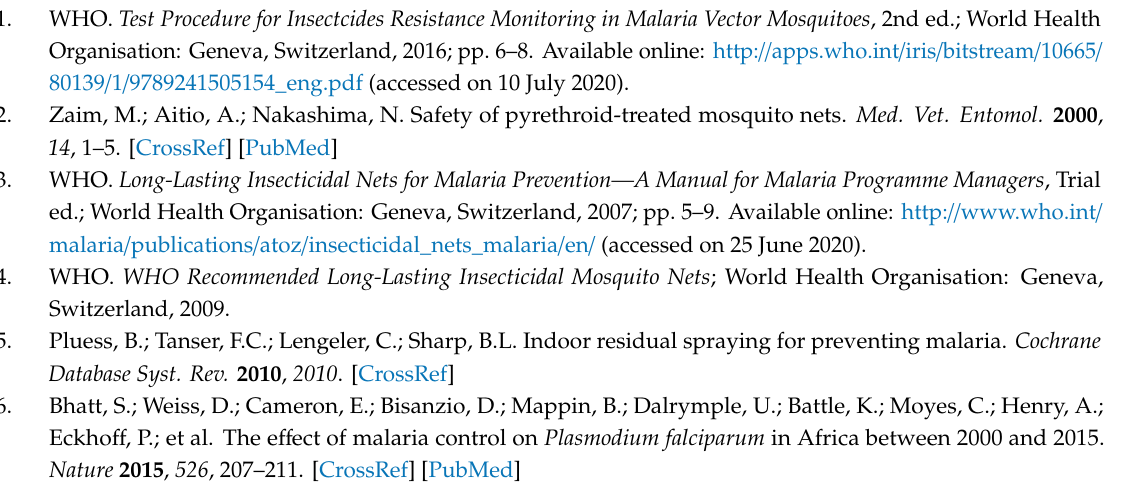
Figure S1. Mosquito genera identified at each surveyed locality, Figure S2. Female’s anophelines species composition across the study area, Figure S3. Parity and Plasmodium spp. infection rates within An. gambiae species complex and of An. funestus s.s., Figure S4. Nucleotide sequences of the 53 GSTe2 haplotypes identified across Africa, Figure S5. Africa-wide diversity pattern of a 729 bp fragment of the GSTe2 gene, Table S1: Detailed period (in years) of collections, Table S2: List of primers used in this study, Table S3: Genetic diversity parameters of GSTe2 gene across